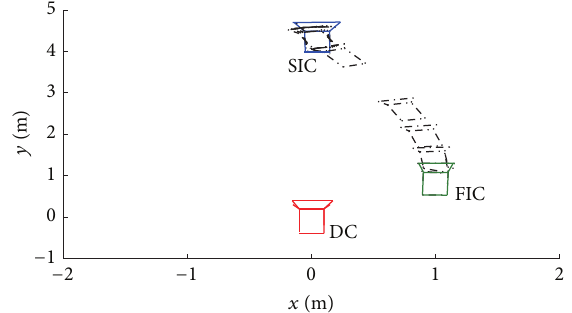
Figure 8: The second step: the robot trajectory. DC is the desired configuration, SIC is the intermediate configuration of the second step, and FIC is the intermediate configuration of the first step. In this step, the robot is moving from FIC to